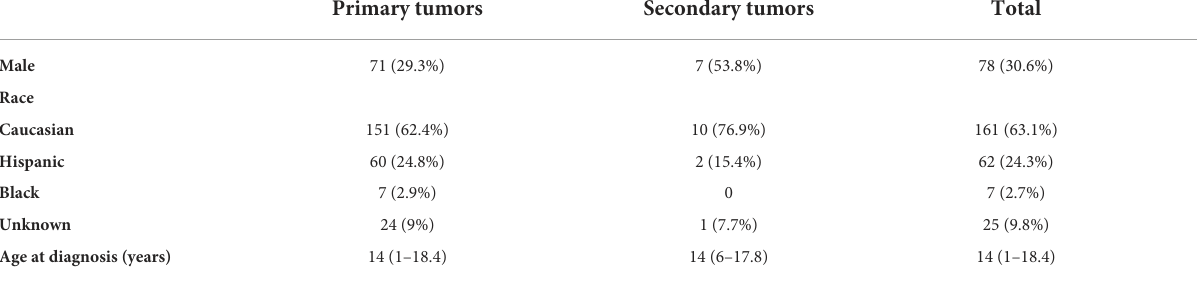
TABLE 2 Demographics of patients.